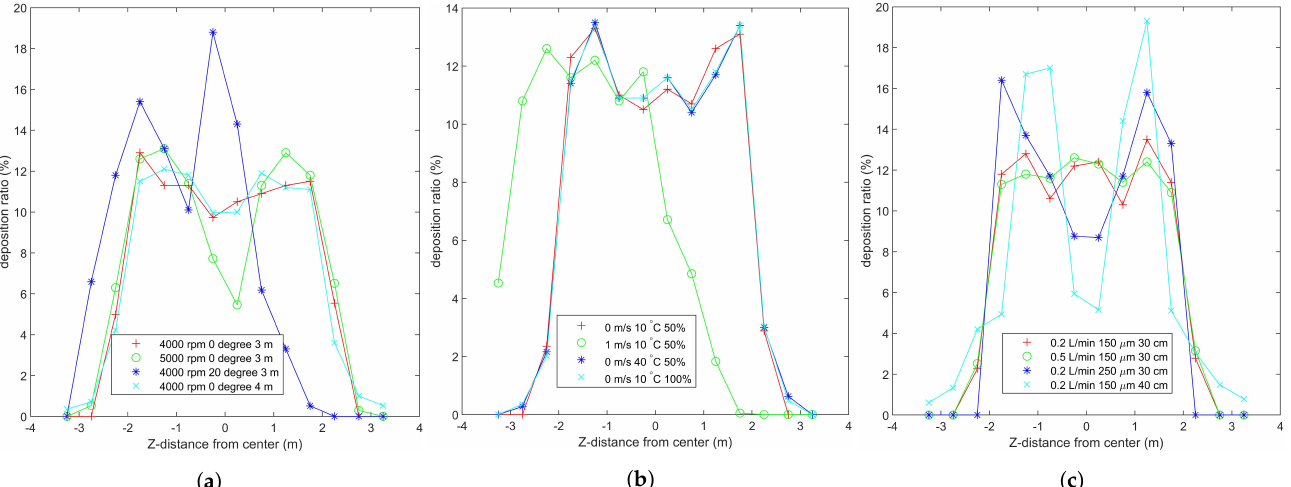
Figure 8. Deposition ratio curve of distance from the center in different states. ( a – c ) shows the droplet deposition ratio under different flight, environment, and nozzle states, which correspond to Figures 9–11, respectively.